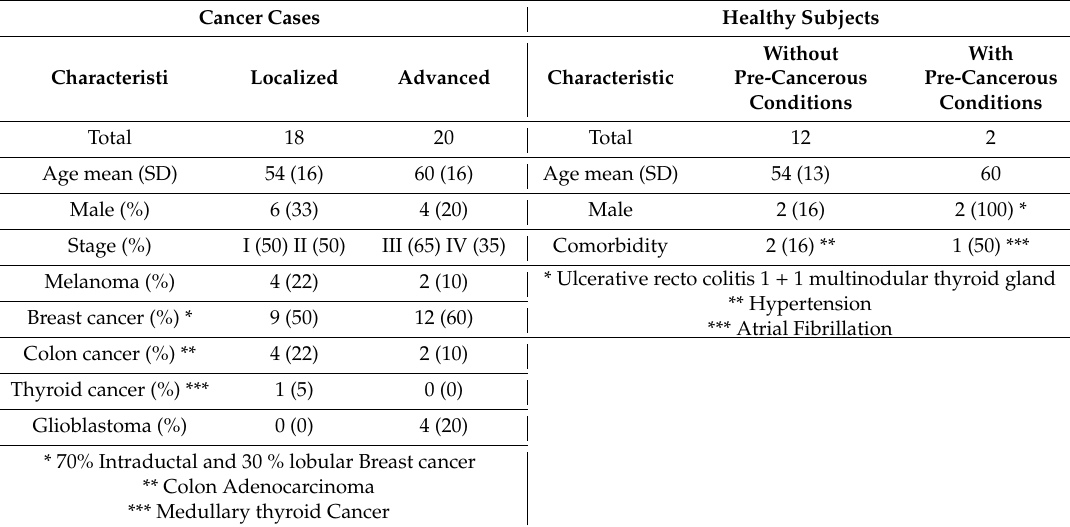
Table 1. Characteristics of volunteers involved.